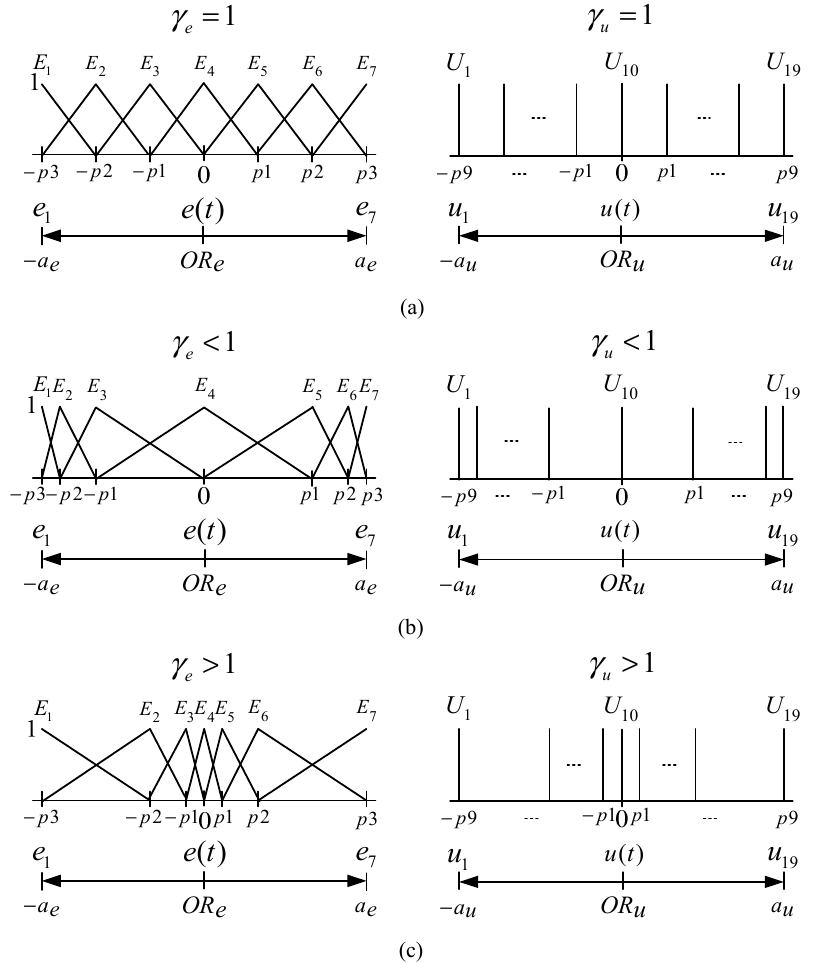
γ γ = 1; ( b ) < 1; and ( c )